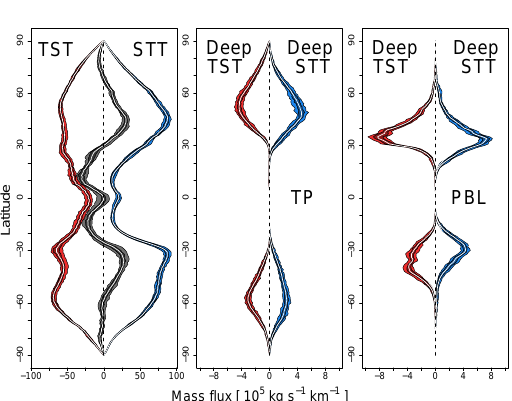
Fig. 7. Meridional distribution of zonally integrated cross- tropopause mass fluxes averaged from 1979 to 2011. The STT, TST, and net (STT-TST) fluxes are shown on the left, and the STT and TST fluxes of deep exchanges only are shown in the middle. The right panel shows the fluxes of deep exchanges into (STT) and out of (TST) the PBL. STT fluxes are shown positive (blue), TST fluxes negative (red) and the net flux is shown in grey. The dashed vertical line at zero mass flux is used for visual guidance and facilitates the identification of areas with net upward or downward flux in the left panel. The shading shows the 5th and 95th (light) and the 25th and 75th (dark) percentiles of the annual values, and the white line is the mean value of the 33yr